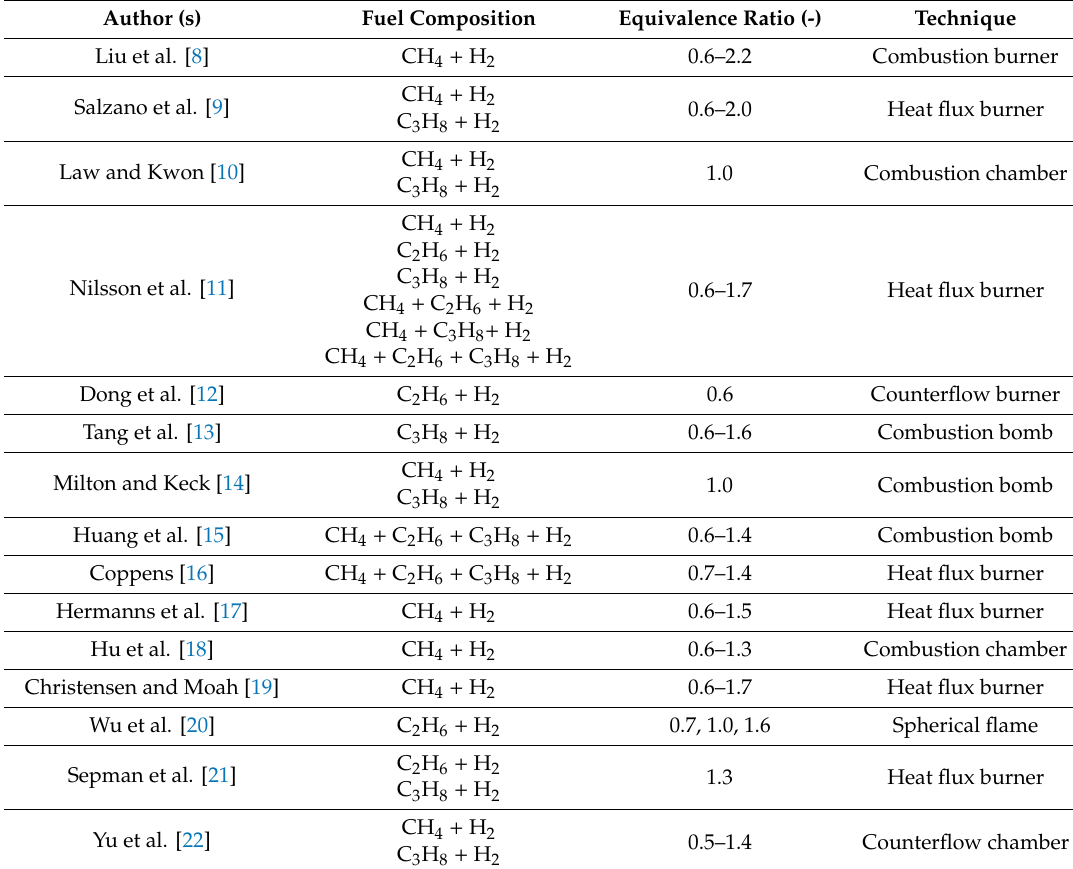
Table 1. List of some of the experimental laminar burning velocity data available in the current literature for alkanes / hydrogen / air mixtures at ambient temperature and pressure.